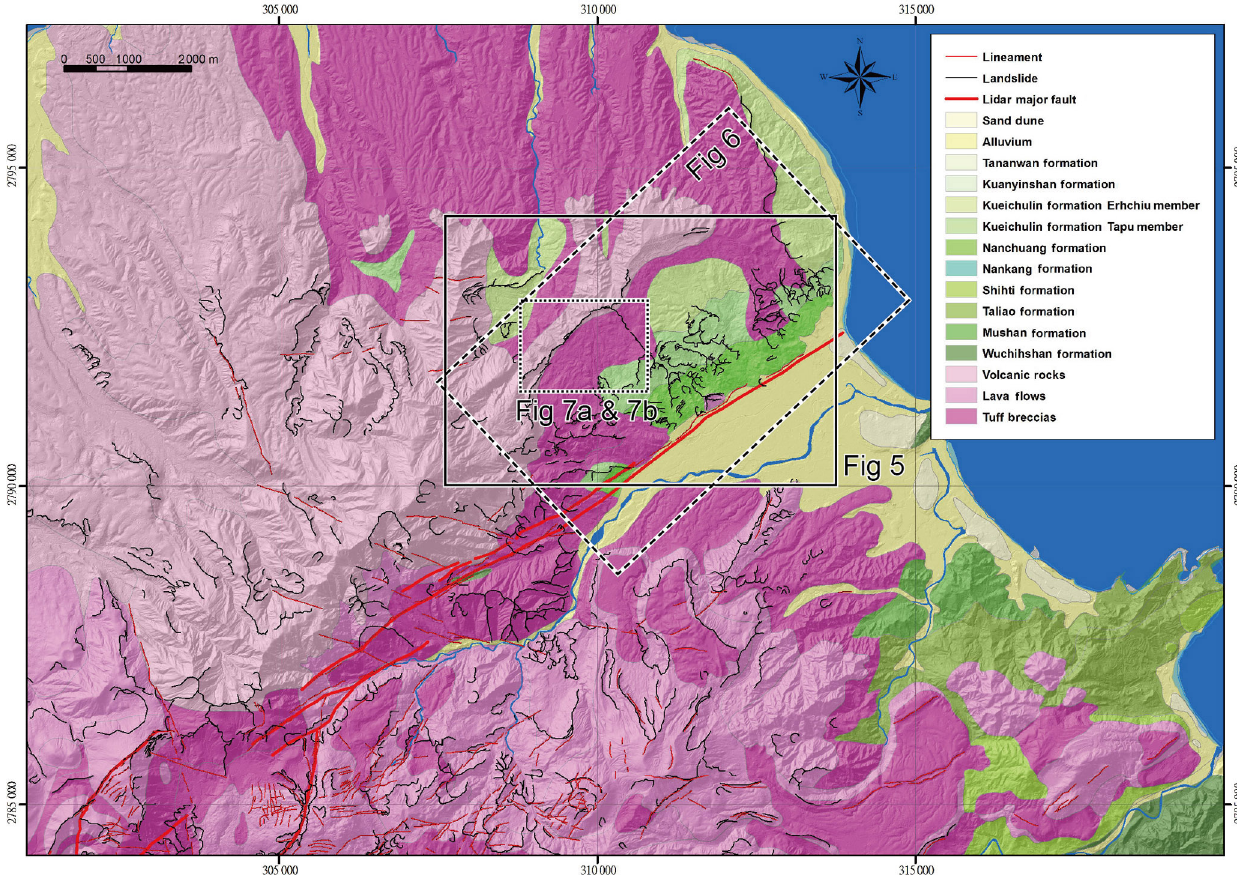
Figure 4. Regional geological map around the study area. Note that different components are illustrated, including faults, lineaments, and landslide scarps. In addition, many landslides are identified around the Tatun Volcano region. The study area was composed of sedimentary rock and superposed by volcanic rocks. Part of the volcanic rocks was eroded away, exposing the underlying Plio-Pleistocene sedimentary